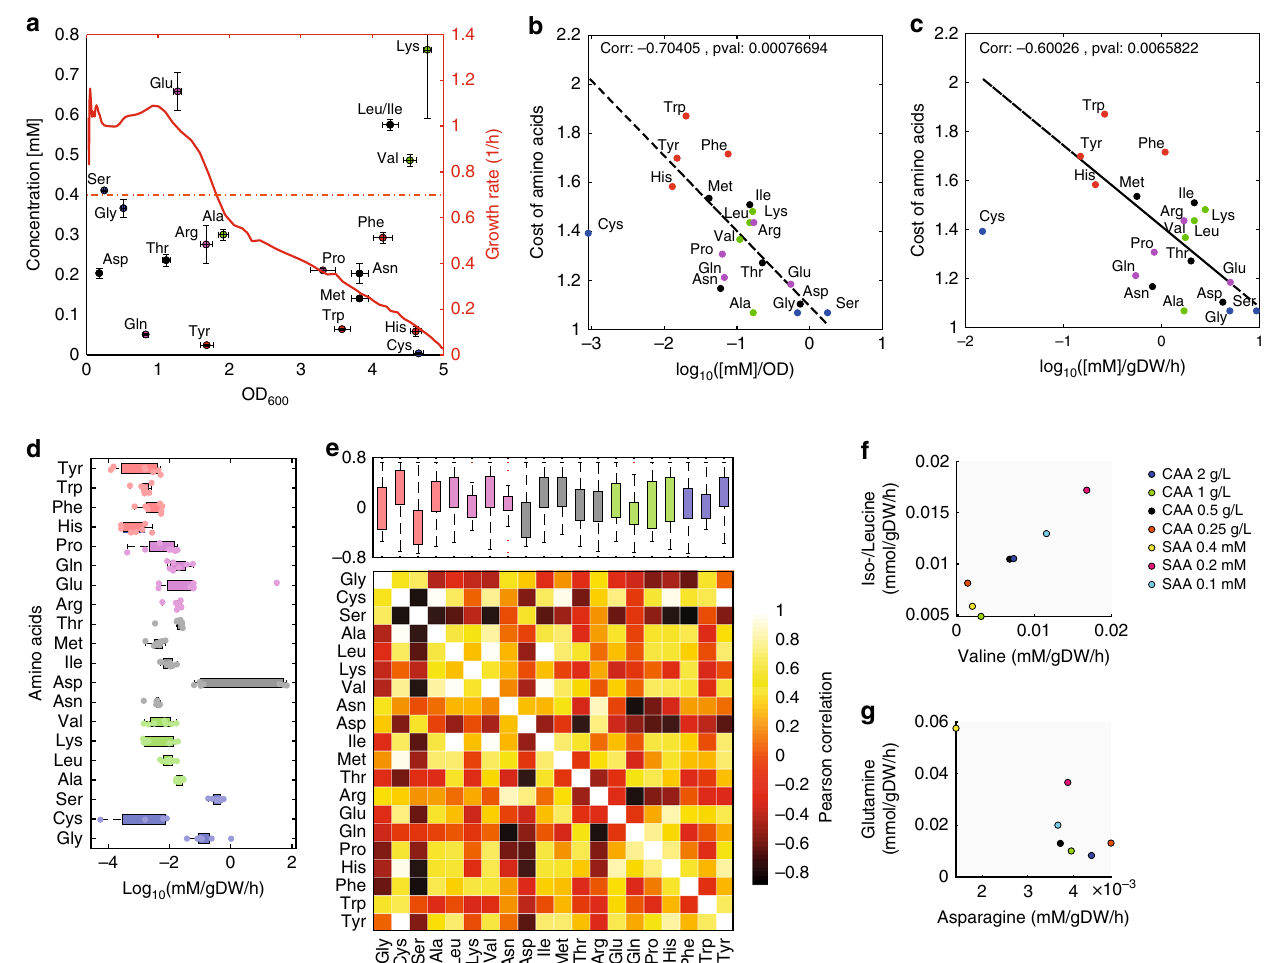
Fig. 4 Consumption vs. cost of amino acids. a Each dot represents one amino acid, while the red line is the instantaneous cellular growth rate. For each amino acid, the initial concentration is related to the OD 600 at which the amino acid has been depleted from the medium. b For each amino acid, its metabolic cost, i.e., the number of high-energy phosphate bonds required for biosynthesis 41 , is compared to the ratio between initial amino acid concentration and culture OD 600 at time of depletion shown in a . c For each amino acid, its metabolic cost 41 is compared to an average estimate of its uptake rate, calculated as the initial amino acid concentration divided by the hours and culture gram of dry biomass (gDW) at time of amino acid depletion. d Distribution of amino acid average uptake rates across seven media containing different initial quantities of amino acids (see also Supplementary Fig. 12). e Heatmap of pairwise correlation between average uptake rates of amino acids across seven tested conditions. Boxplot of pairwise correlation for each amino acid. Box edges correspond to 25th and 75th percentiles, whiskers include extreme data points, and outliers are shown as red plus signs. f Average uptake rates of valine against iso-/leucine. g Average uptake rates of asparagine against